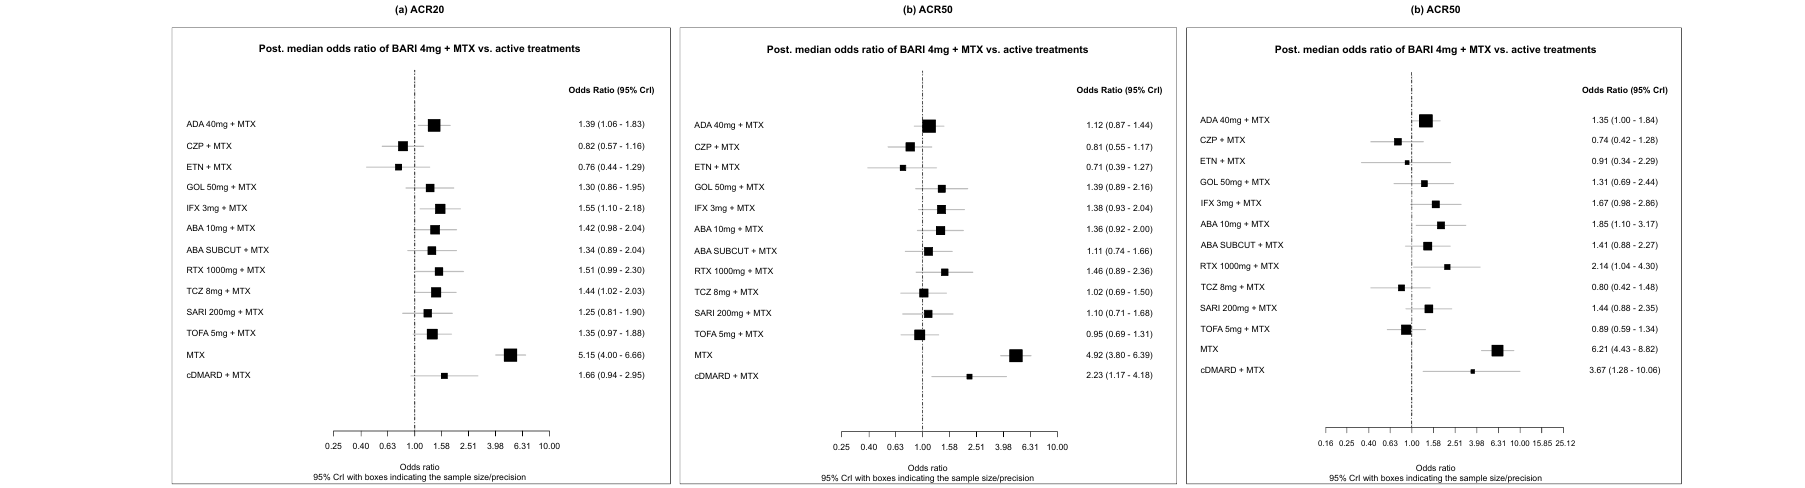
Figure 5. Forest Plots (ACR20/50/70) (MTX-IR Population; Sensitivity Analysis [2])